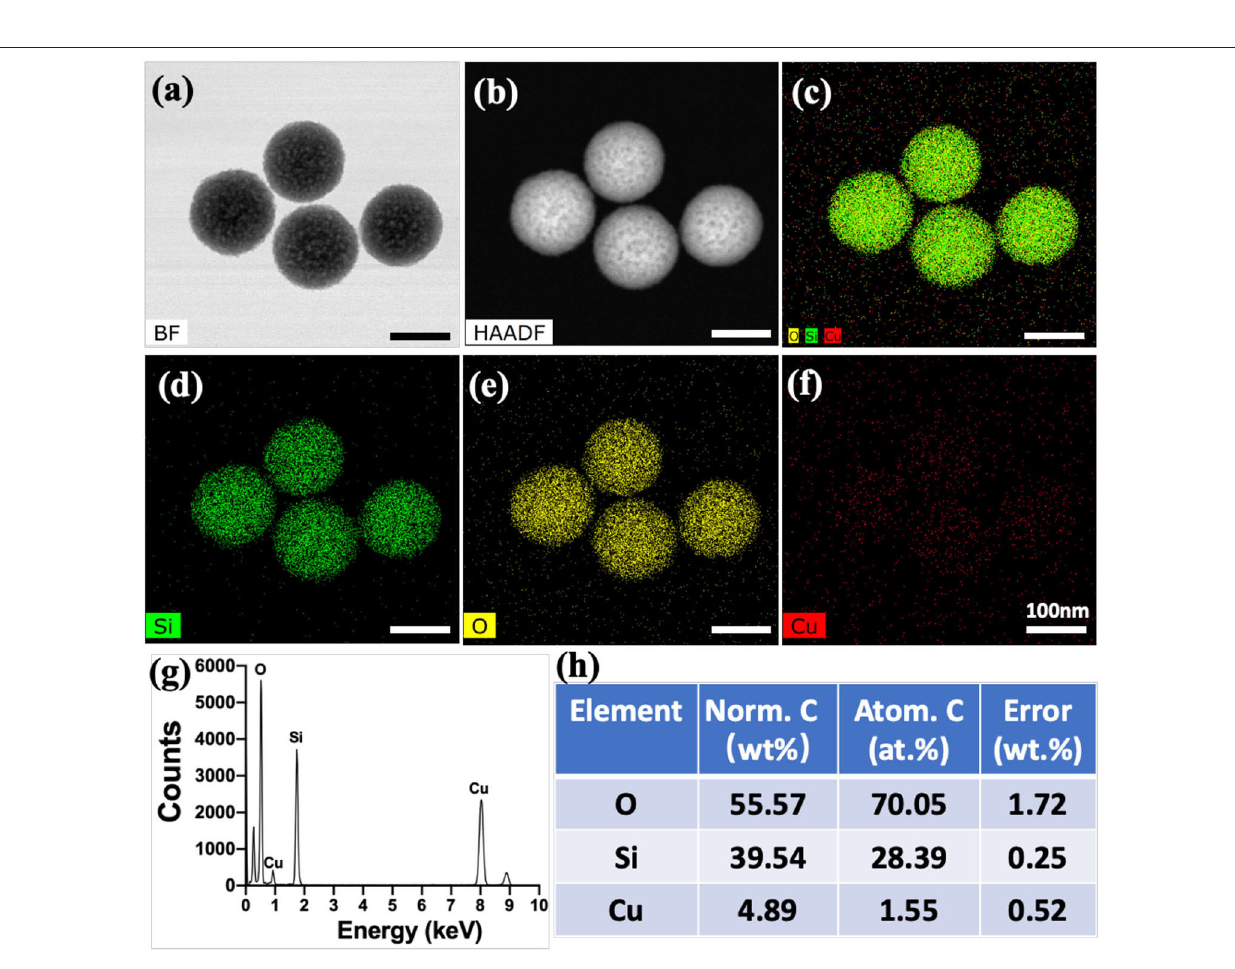
FIGURE 2 | Transmission electron microscope images of Cu-containing mesoporous silica nanospheres (Cu-MSN) in bright field (BF) model (a) and high-angle annular dark field (HAAD) model (b) . Energy-dispersive spectrometry element mapping images of all (c) , Si (d) , O (e) , and Cu (f) elements distributed in Cu-MSN. Energy-dispersive spectroscopy analysis (g,h) of